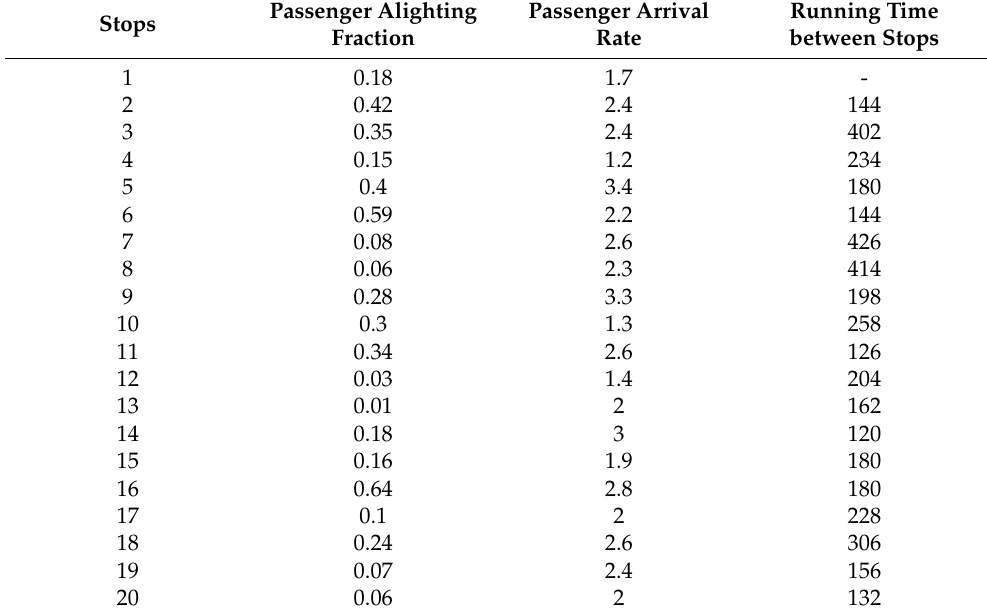
Table A3. Values of stochastic parameters in scenario three.